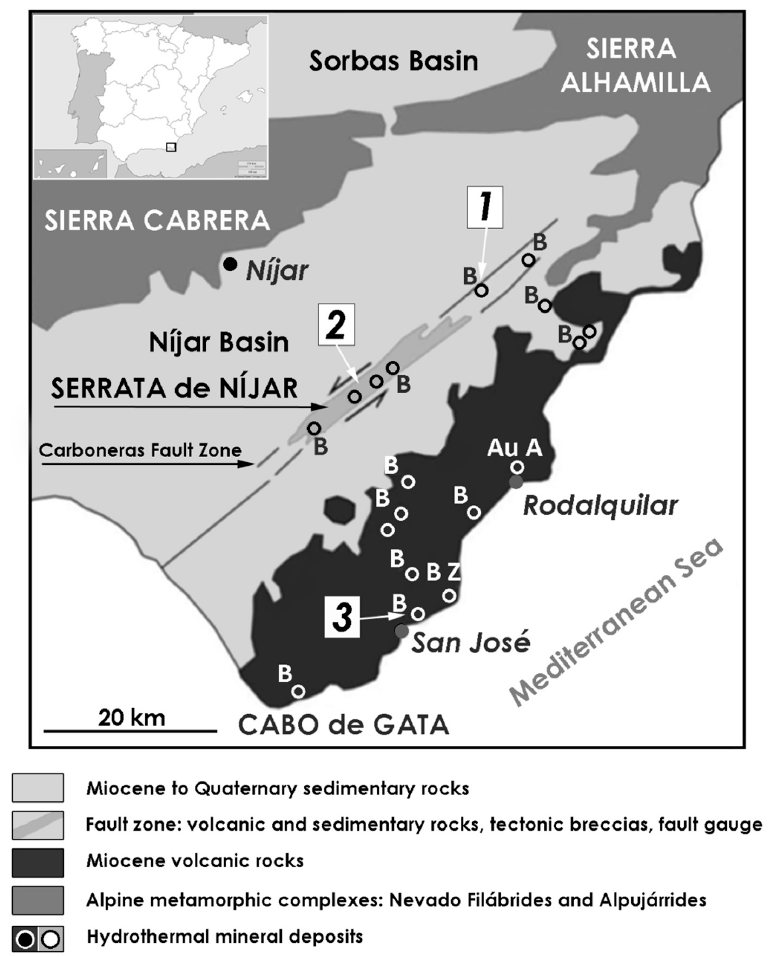
Figure 7. Simplified scheme depicting the major geological units of the Cabo de Gata region and the location of the studied quarries. 1: Los Trancos. 2: Cortijo de Archidona. 3: Morrón de Mateo. A: alunite; Au: gold; B: bentonite, Z: zeolite. Modified from [91].